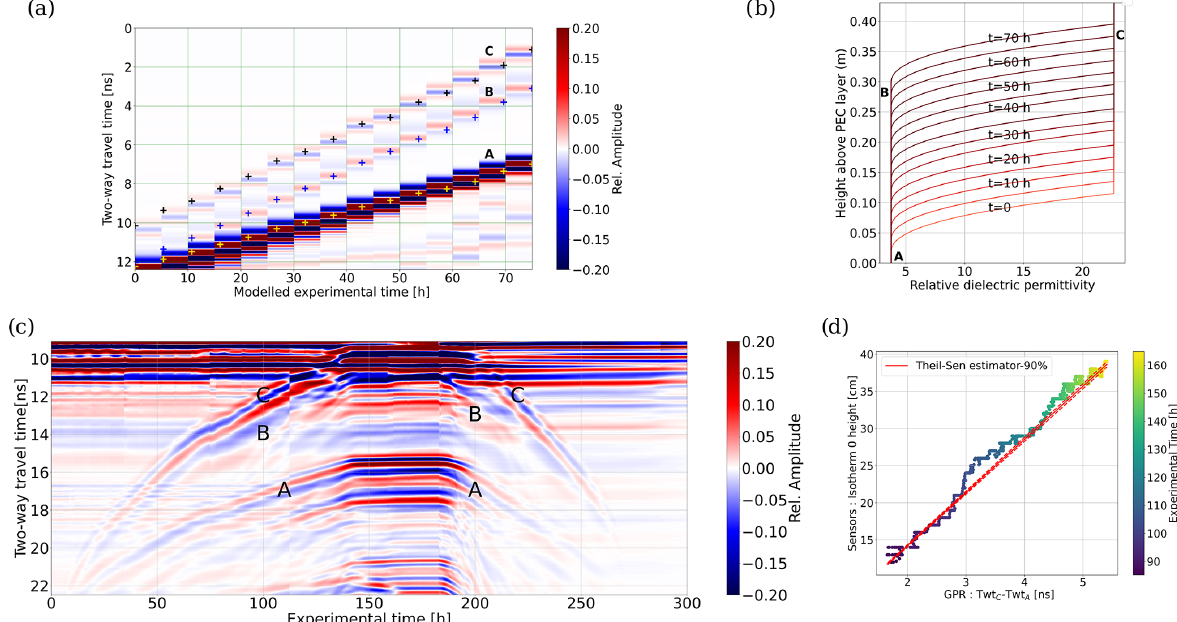
Figure 3. (a) Simulated radargram with permittivity distributions shown in (b) . (c) Experimental radargram displayed with normalised amplitude. Labelled (A), (B) and (C) reflections correspond to the permafrost base, bottom and top of the transitional zone, respectively. Crosses in (a) are computed as TWT using permittivity distributions in (b) , where B and C positions are indicated for the t = 65h. TWT stands for Two-Way travel Time. (d) The difference of TWT C and TWT A as a function of 0 ◦ C-isotherm